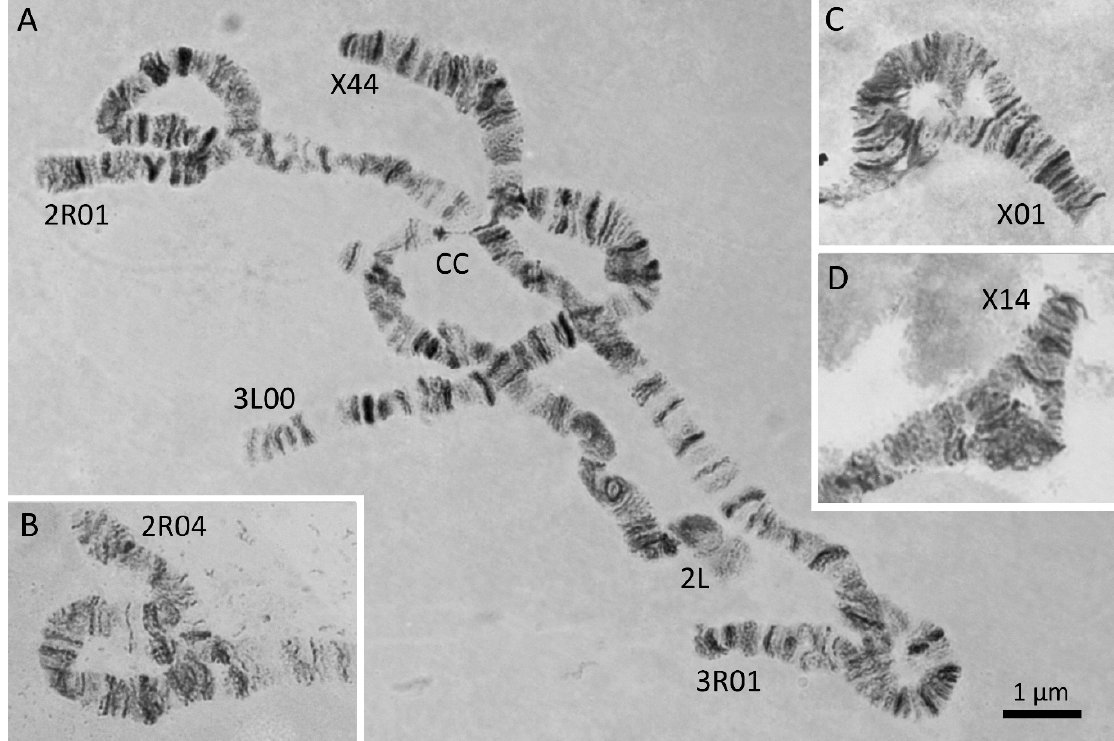
Figure 4. Inversions in polytene chromosomes of An. messeae and An. daciae . The specimens in the Moscow region are characterized by the presence of 4 highly polymorphic inversions X1, 2R1, 3R1, and 3L1, and 2 rare endemic inversions X4 and 2R4. A rare karyotype X44, 2R01, 3R01, and 3L00 in An. messeae is shown on panel A . Another rare inversion heterozygote, 2R04, in An. daciae is shown on panel B . Inversion heterozygotes X01 in An. daciae and X14 in An. messeae are indicated on panels C and D , respectively. СС stands for chromocenter.